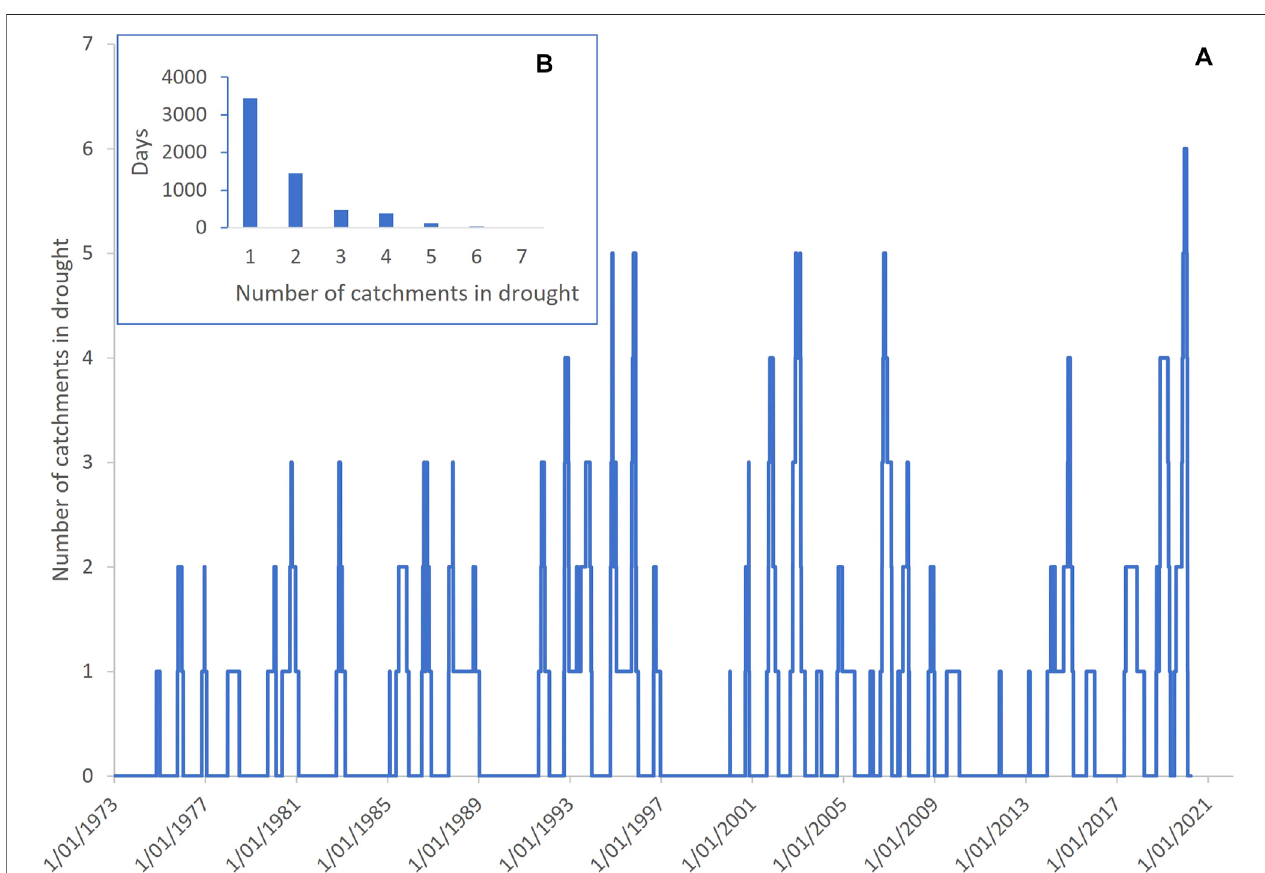
FIGURE 3 | Drought synchrony across the rivers of the Queensland Murray-Darling Basin between 1973 – 2020 showing that the 2018 – 2020 drought had the greatestsynchrony. (A) showsthenumberofriversindroughtoneach dayand (B) showsthesumofdayswithdifferentnumberofriverssimultaneouslyindrought,with zero rivers